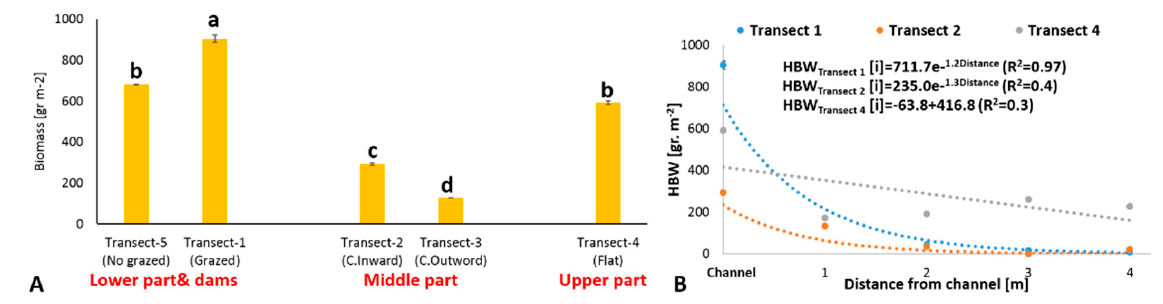
Figure 6. The herbaceous biomass weight in the different wadi plots. ( A ) The herbaceous biomass weight in the channel of the different transects; ( B ) the biomass weight distribution over the southern grazed transects. Lines on the graph: mean